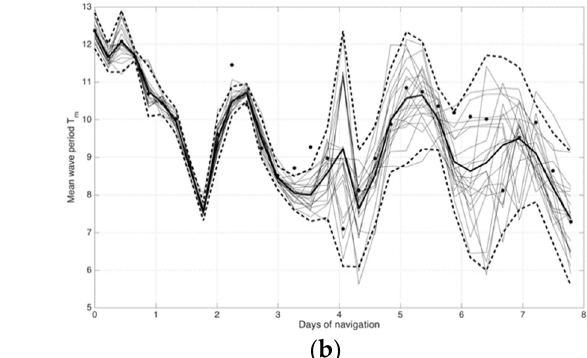
Table 1. Main characteristics of the ship considered in the simulation.